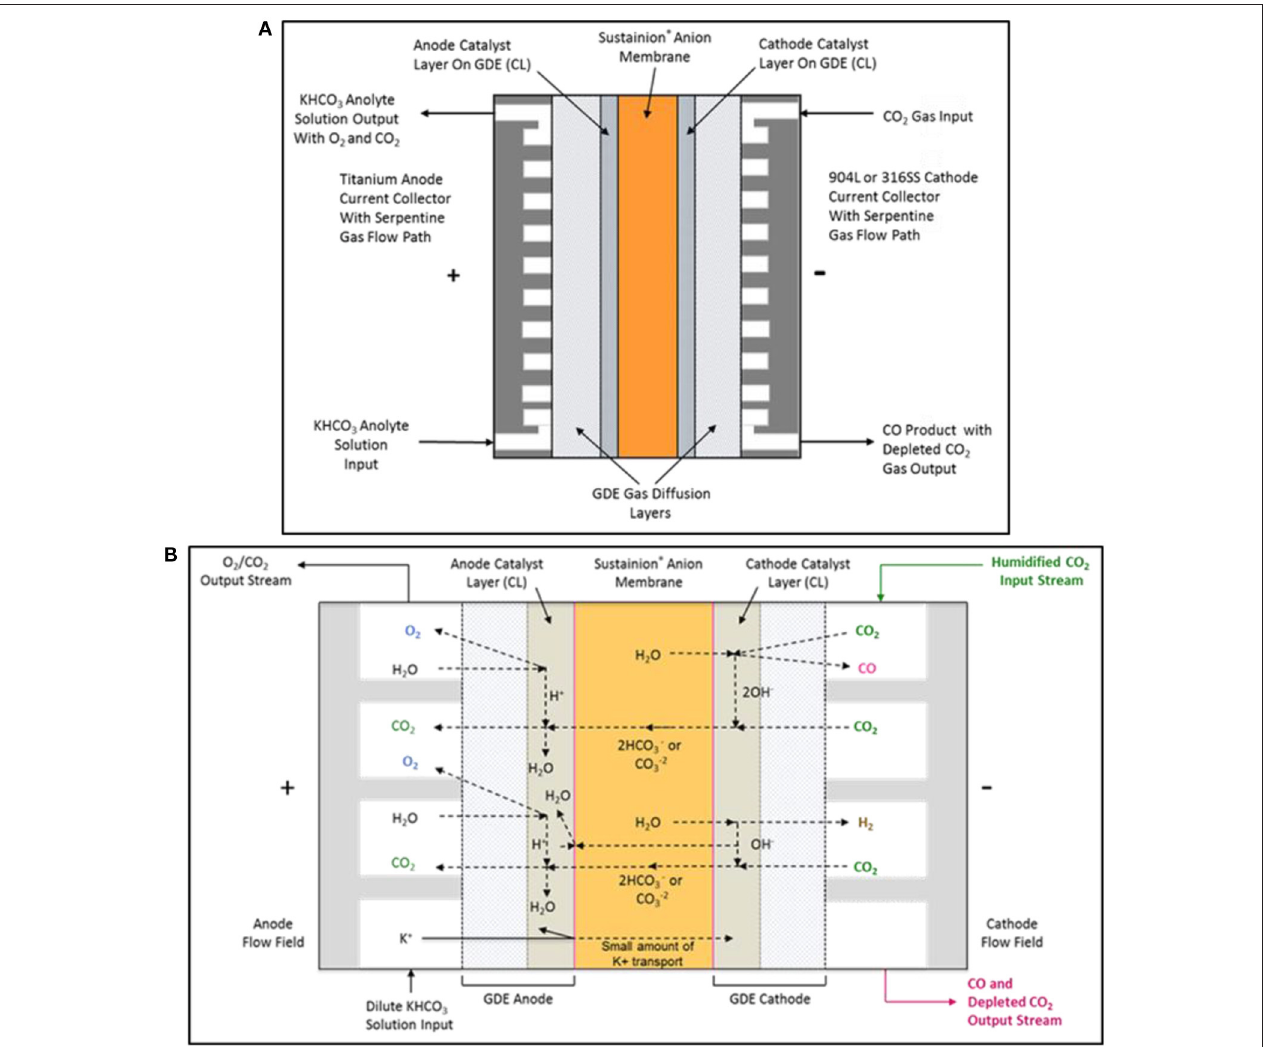
FIGURE 6 | The DM electrochemical CO 2 cell configuration is shown in (A) . The proposed electrochemical CO 2 cell internal chemistry showing the main reactions and ionic specie flow paths are shown in (B)